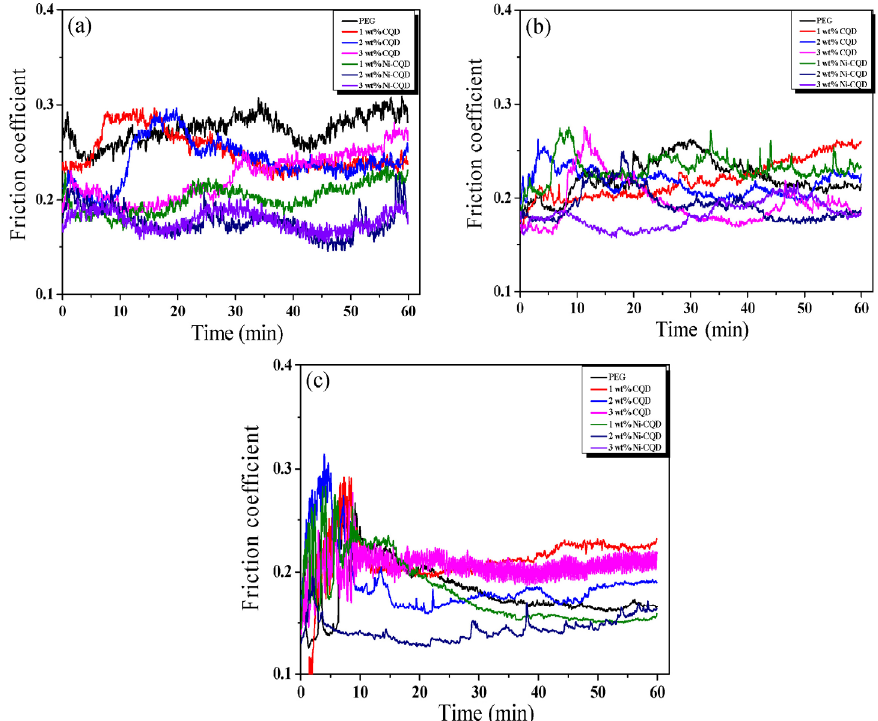
Fig. 5 Variation of friction coefficient as a function of the friction time at 25 mm/s for 60 min under the different loads: (a) 8 N; (b) 20 N; (c) 100 N.